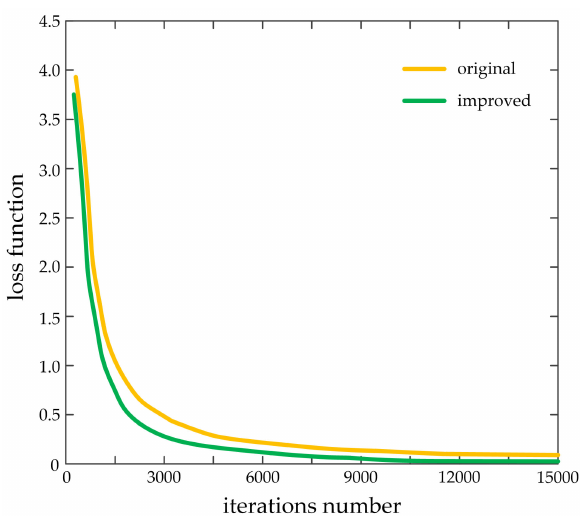
Figure 4. The change curves of loss function about original and improved